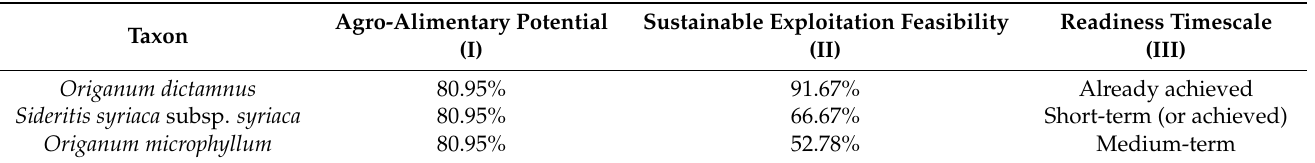
Table 1. Top cases of local endemic Cretan plants with strong agro-alimentary potential (Level I evaluation) associated with high feasibility and readiness timescale for sustainable exploitation (Level II and III evaluations, after [22]). Agro-Alimentary Potential Sustainable Exploitation Feasibility Taxon Origanum dictamnus Sideritis syriaca subsp.